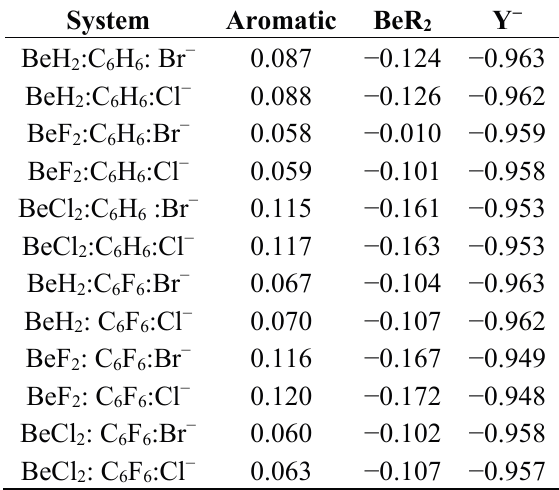
Table 9. Charge (e) of the monomers in the ternary complex.